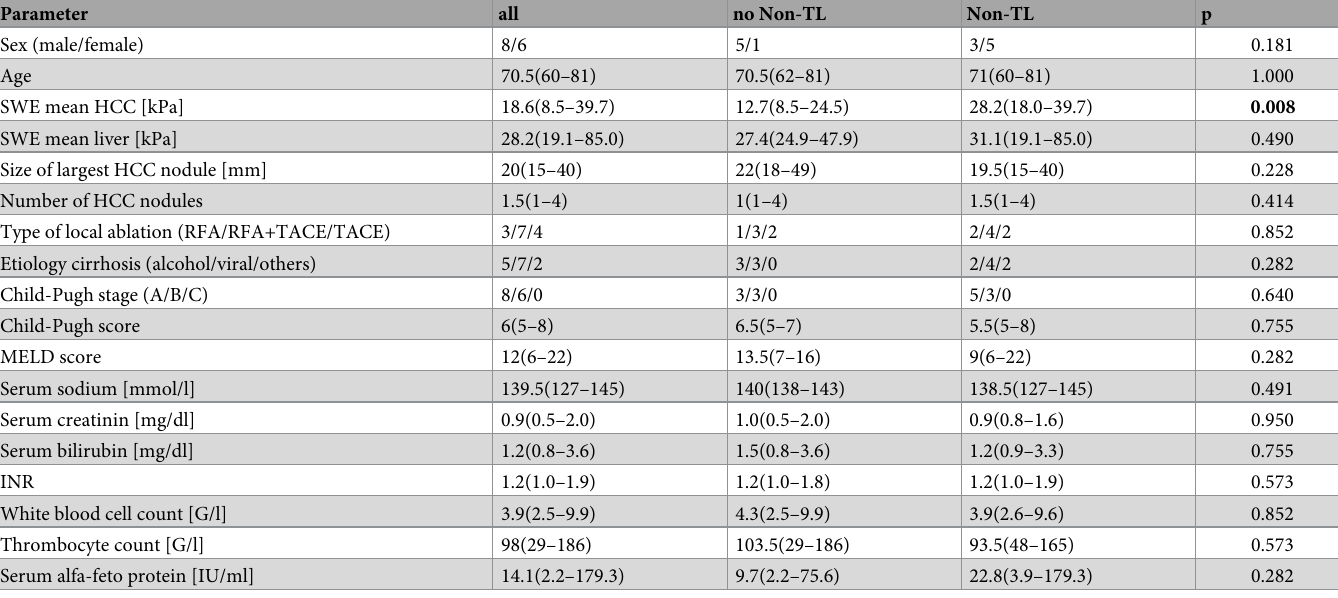
Table 1. Patient characteristics before local ablative therapy, stratified for occurrence of